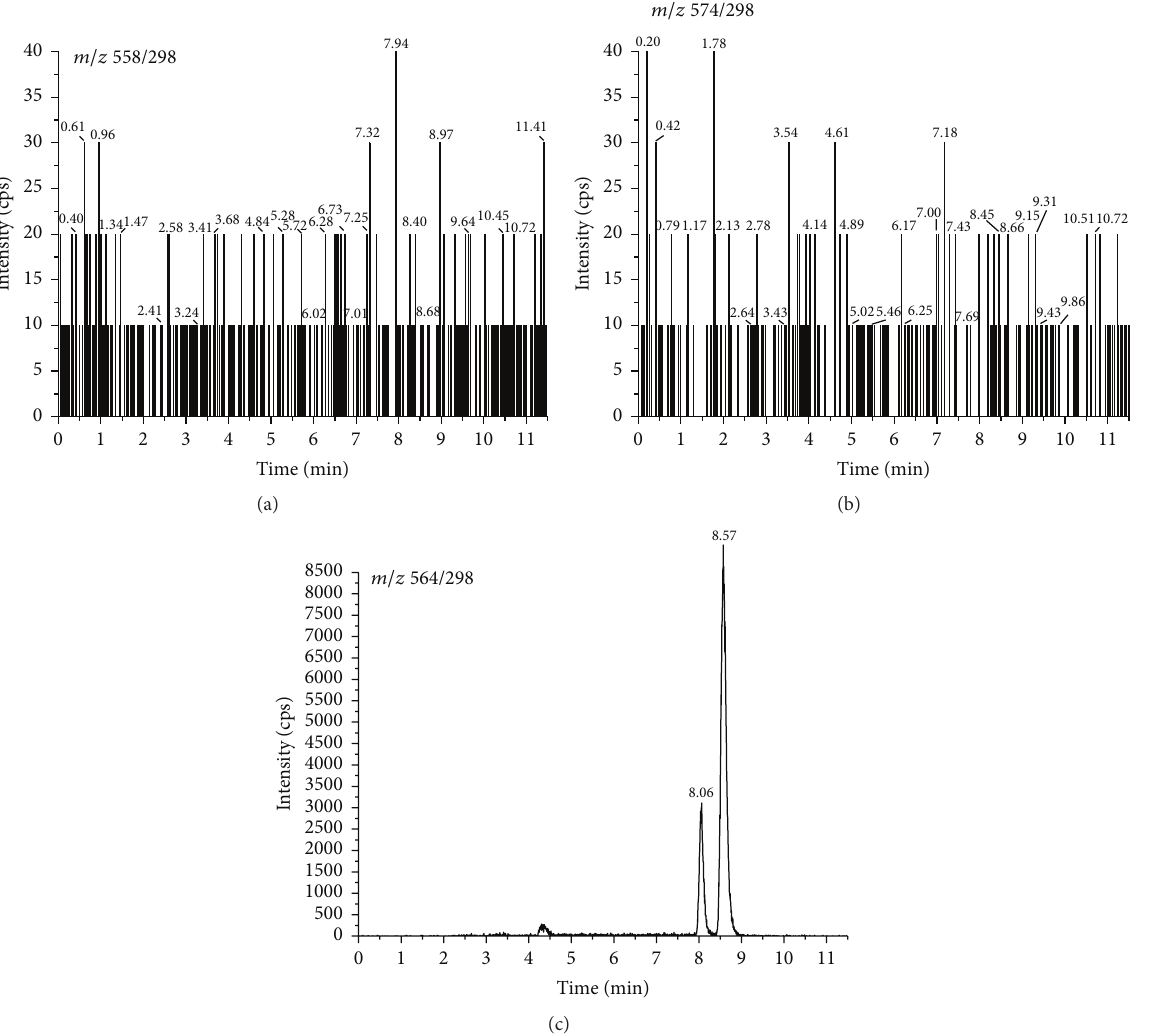
Figure 1: The representative MRM chromatograms for blank sample added with